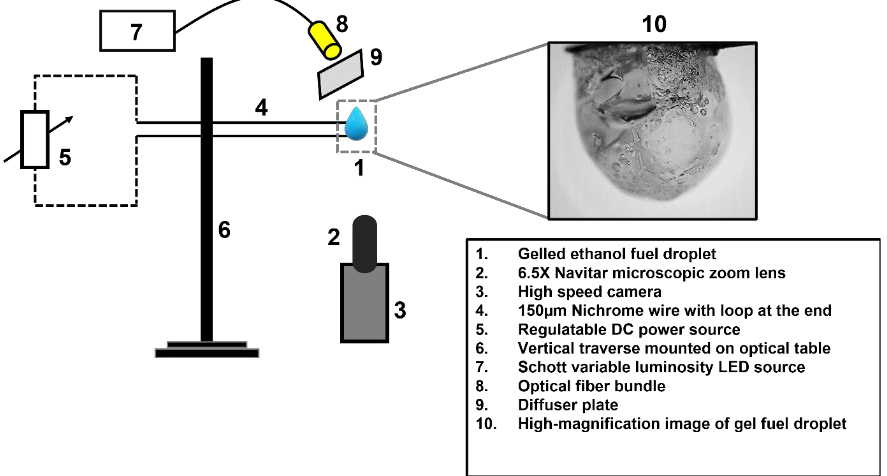
Figure 7. The schematic diagram of the experimental test facility for capturing the oscillatory combustion behavior of the ethanol-gel fuel droplets.